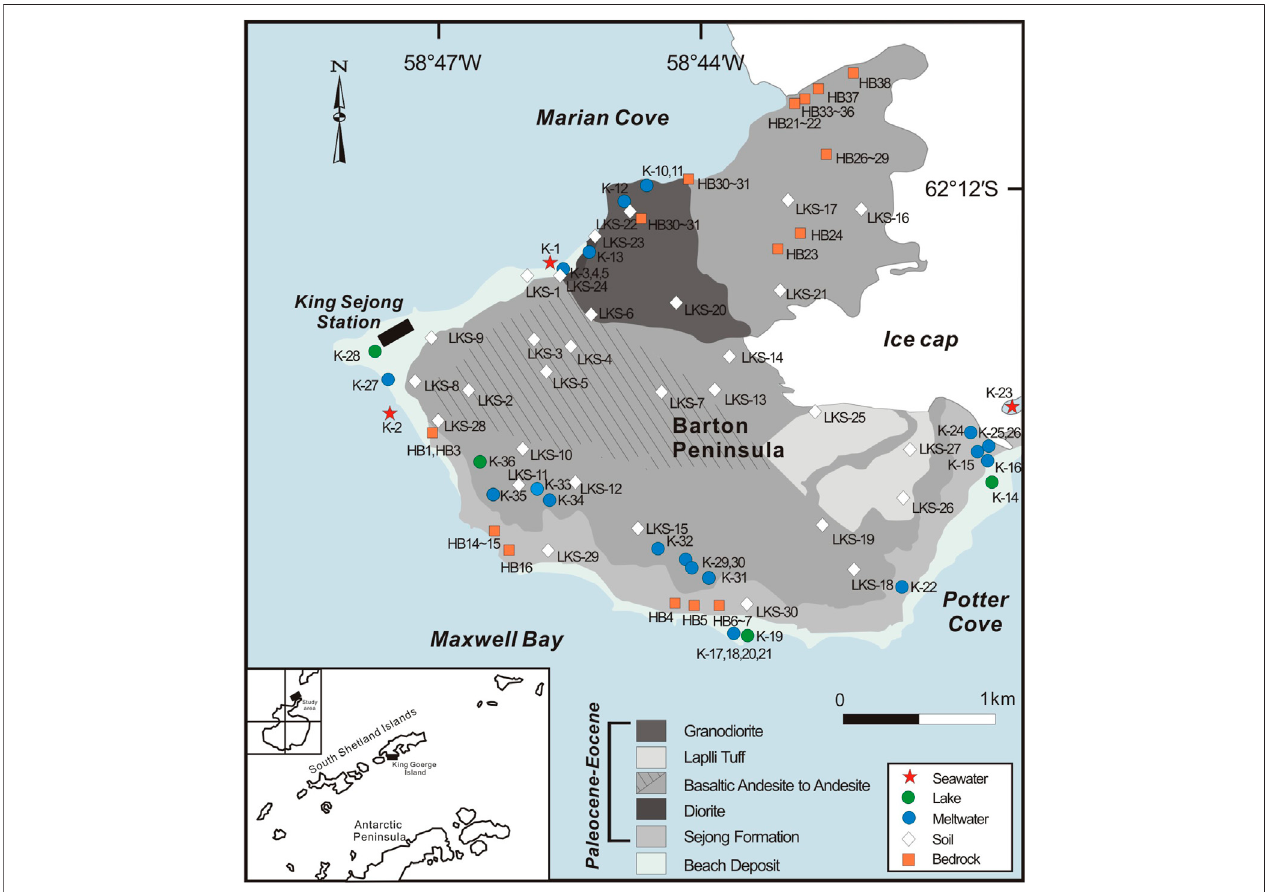
FIGURE 1 | Map showing sampling locations on Barton Peninsula, King George Island, West Antarctica. The sampling locations for suspended sediment are the same as those for water sample.